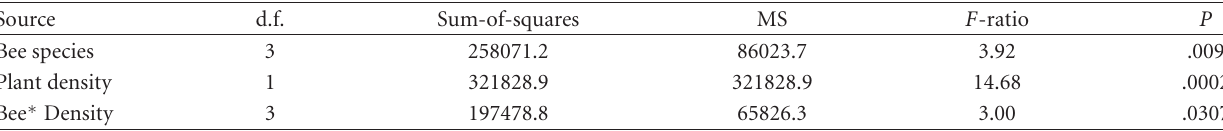
Table 3: Analysis of variance with pollinator species and plant density on the number of flowers visited per patch during one foraging bout by bumble bees and honeybees. Source d.f. Sum-of-squares MS F -ratio P Bee species 3 258071.2 86023.7 3.92 .009 Plant